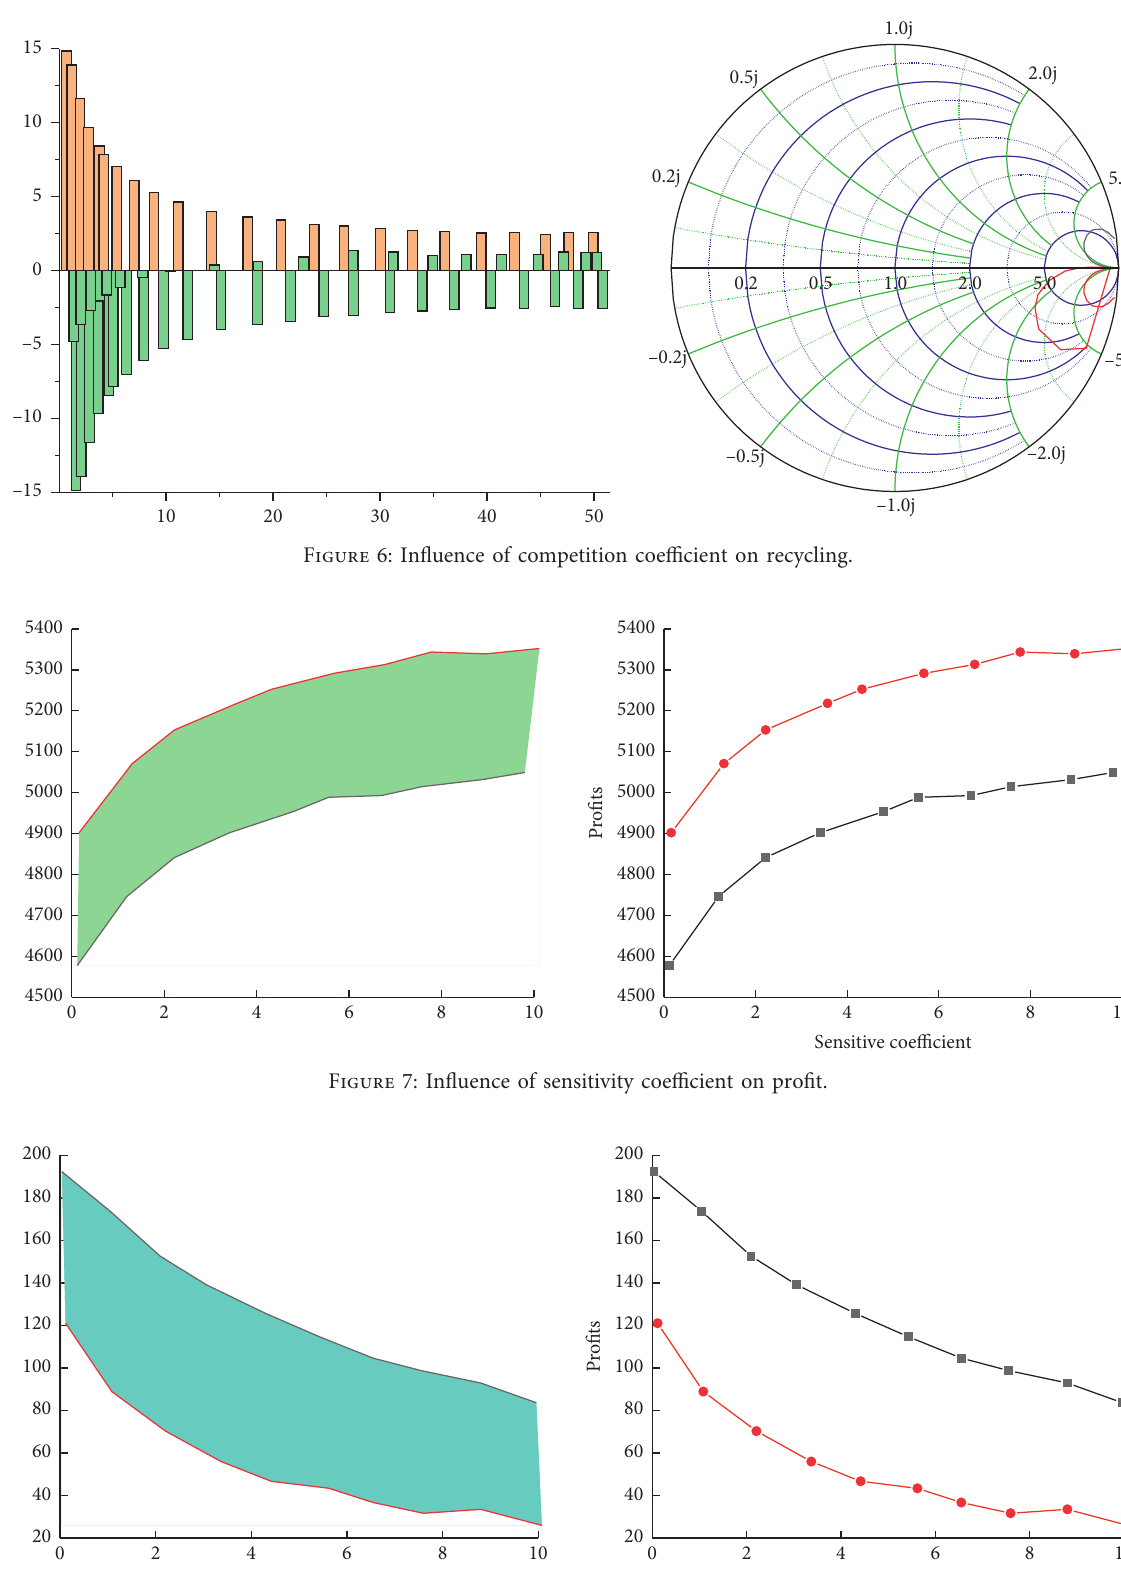
Figure 8: Influence of sensitivity coefficient on third-party